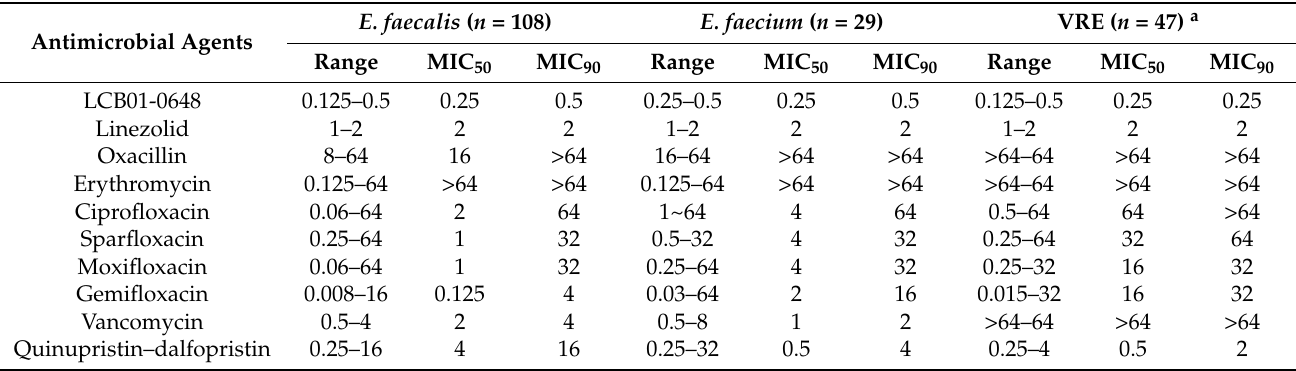
Table 3. Minimum inhibitory concentrations (MICs) of LCB01-0648, linezolid, oxacillin, erythromycin, ciprofloxacin, sparfloxacin, moxifloxacin, gemifloxacin, vancomycin, and quinupristin–dalfopristin for clinical isolates of Enterococci.